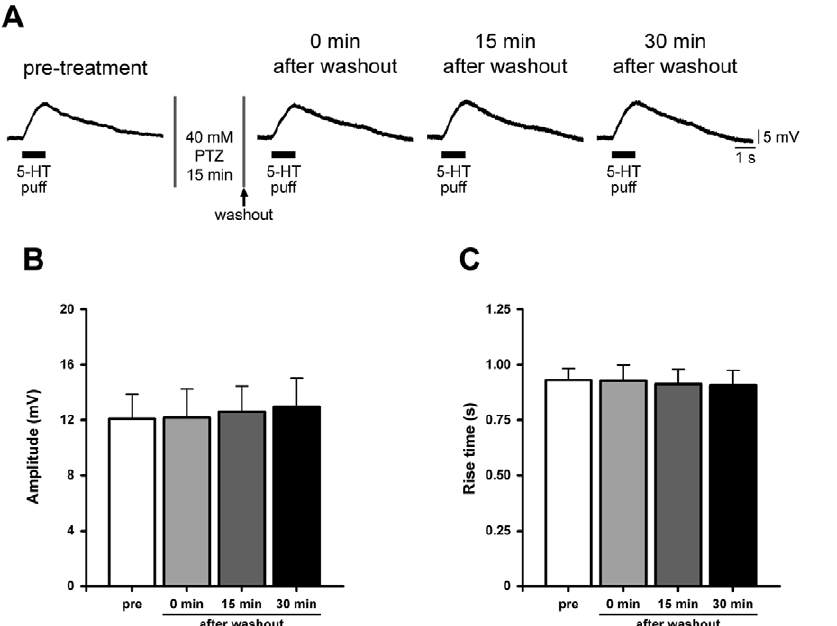
Figure 2. PTZ application does not compromise B2 postsynaptic response to locally applied neurotransmitter. (A) Sample electrophysiological recordings showing the response to locally applied 20 m M serotonin pulses (5-HT for 1 s; 10 psi) before and after the exposure to PTZ (at 0, 15 and 30 minutes after drug washout). (B) Bar graph of the mean depolarization evoked by neurotransmitter application. No detectable changes were observed among the examined groups. (C) Bar graph of the corresponding rise times.